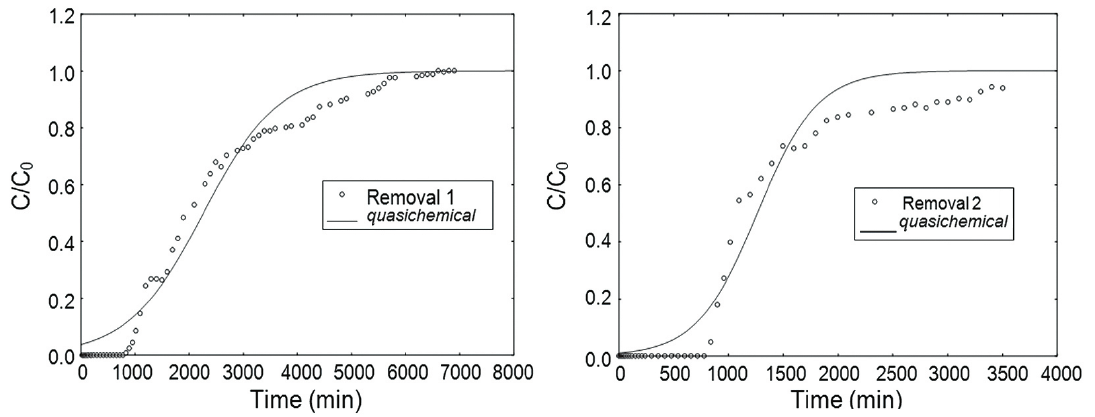
Figure 4. Fitting of the Adams – Bohart model of beds regenerated by CaCl